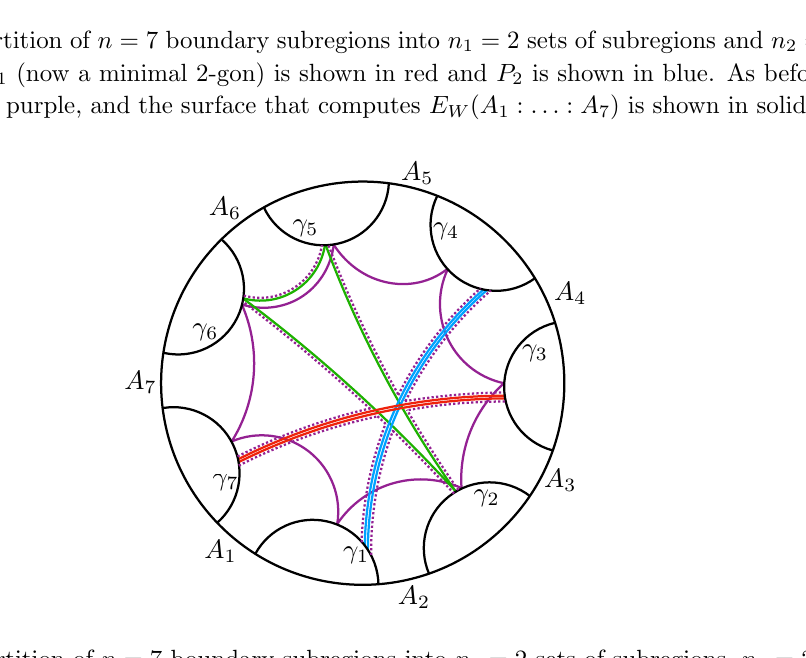
Figure 5 . A partition of n = 7 boundary subregions into n 1 = 2 sets of subregions, n 2 = 2 sets of subregions, and n 3 = 3 sets of